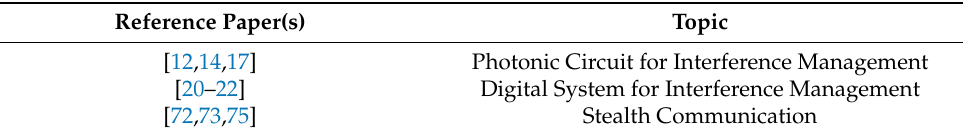
Table A2. Previous